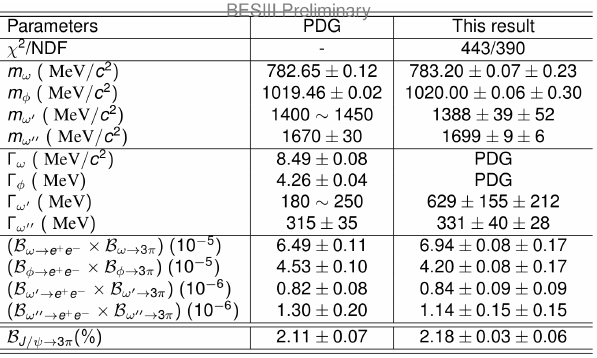
Table 1. Fit results of the fit to the π + π − π 0 cross section.